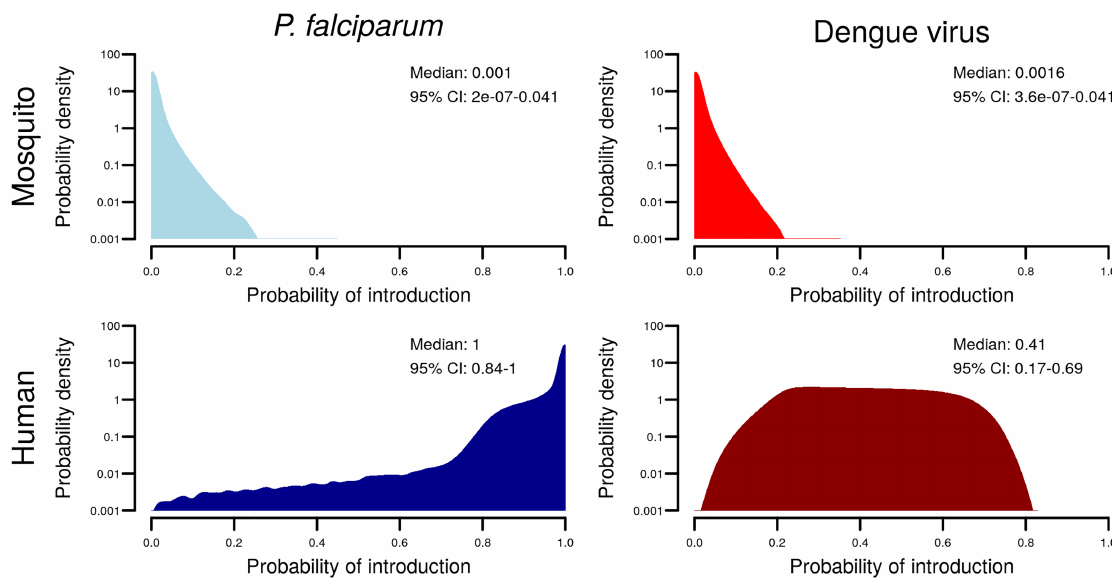
Fig 4. Distributions for the probability of introduction by each pathway. The density (log scale) for the probabilityof introductionvia each pathway across 1 million simulations for P . falciparum (left column) and denguevirus (right column)and for the two pathways of introduction: infected mosquitoes(top row) and infected humans (bottom row). Each panel provides the median and 95% credible interval.